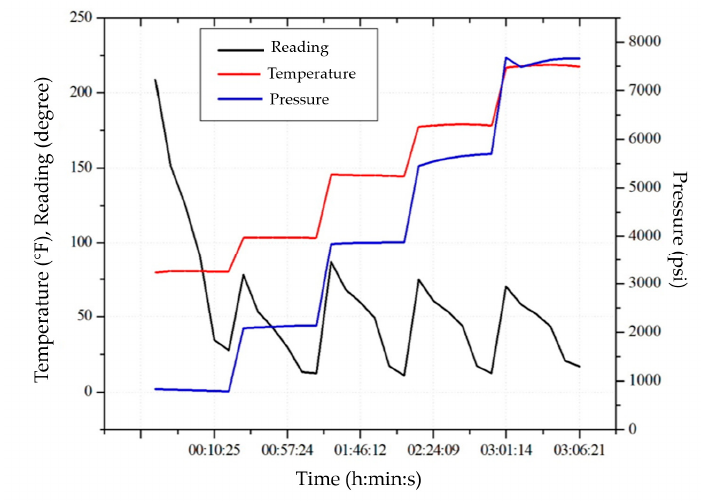
Figure 6. Rheological behavior of EDF at HPHT conditions.